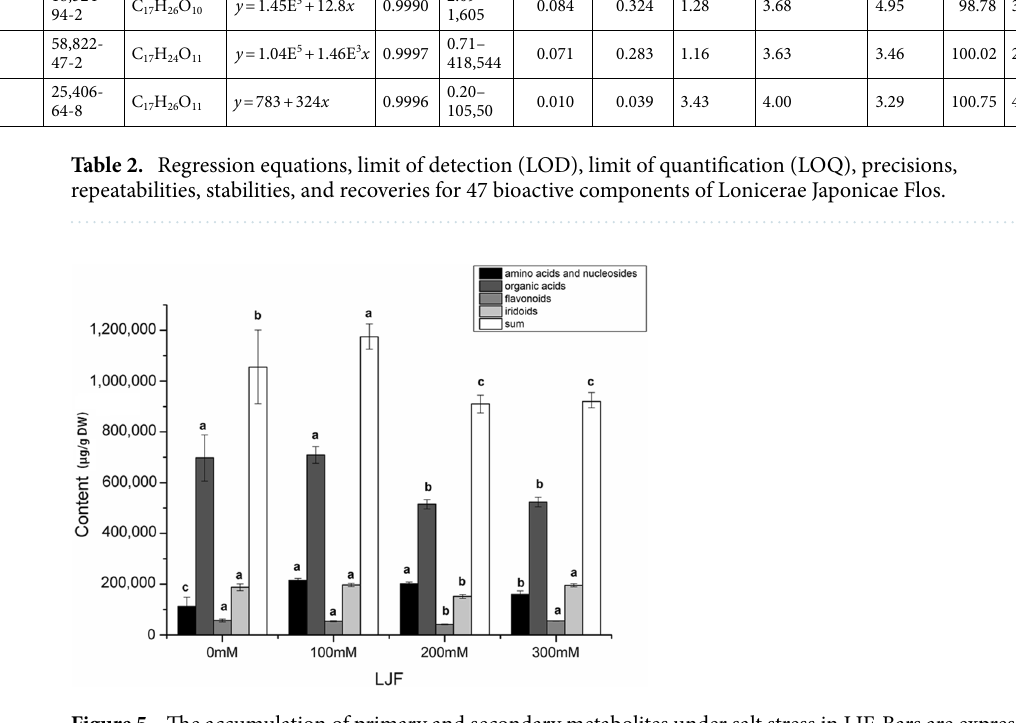
Figure 5. The accumulation of primary and secondary metabolites under salt stress in LJF. Bars are express as the mean ± SD ( n = 5), the letters of bars indicate significant differences at p <